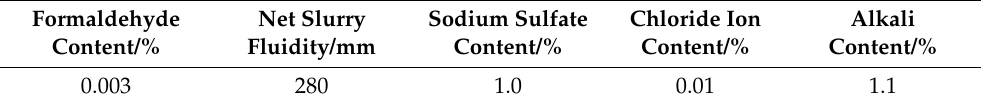
Table 3. Granulated ground blast slag performance test results.